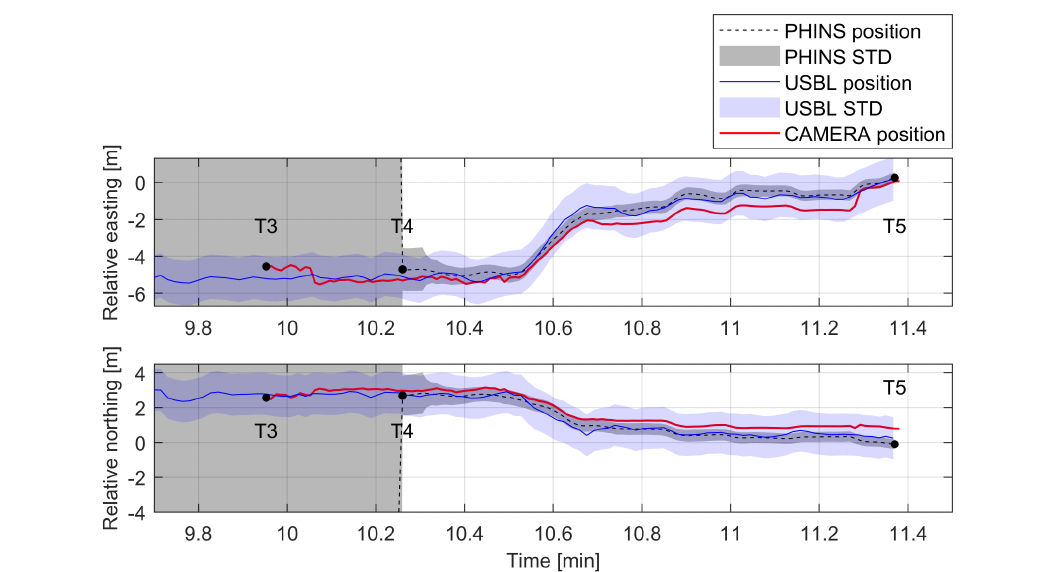
Figure 15. The comparison between PHINS data, USBL data, and visually estimated pose acquired during the